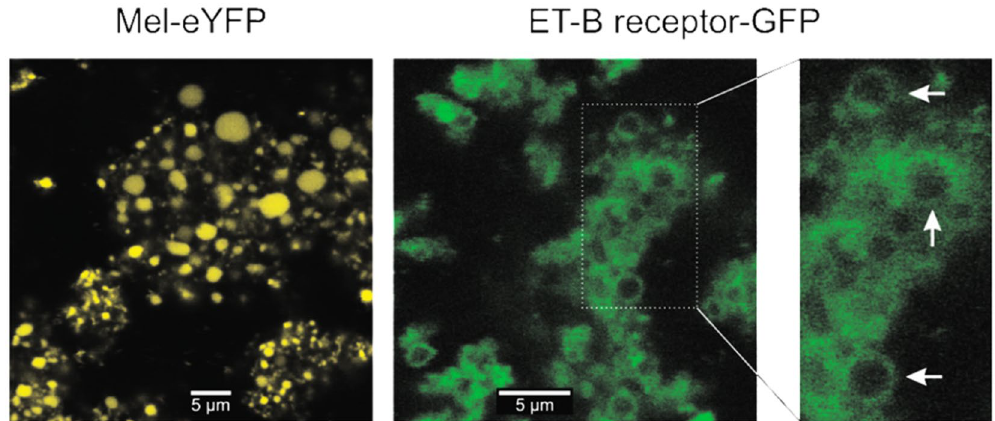
Figure 1. Comparison of the luminal versus transmembrane topology of in vitro translated Mel-eYFP and ET-B-GFP in insect cell extracts. Analysis was performed by confocal laser scanning microscopy after allowing vesicular structures to swell for 15 min under hypoosmotic conditions in PBS. Mel-YFP fluorescence (left panel) was evenly distributed within larger vesicles, indicating intraluminal localization. By contrast, ET-B-GFP fluorescence (right panels) was enhanced in vesicle membranes (see arrows in inset with higher magnification), suggesting a transmembrane topology of the